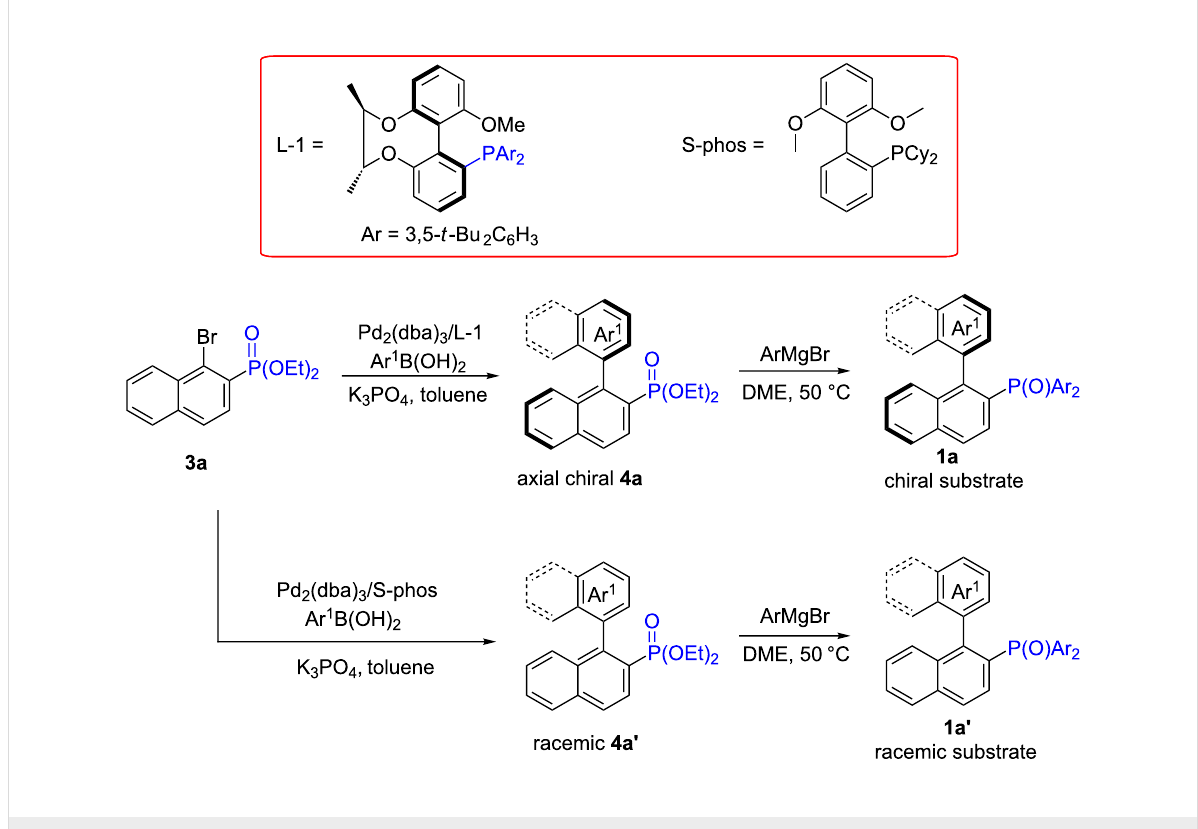
Scheme 2: Synthesis of chiral and racemic